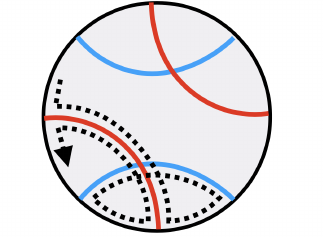
Figure 11. Tracing, on the chord diagram, a face of the cut graph’s dual: In this diagram, there is only 1 face, so the Euler characteristic is χ = V − E + F = 1 − 4 + 1 = − 2. The surface is a double torus.